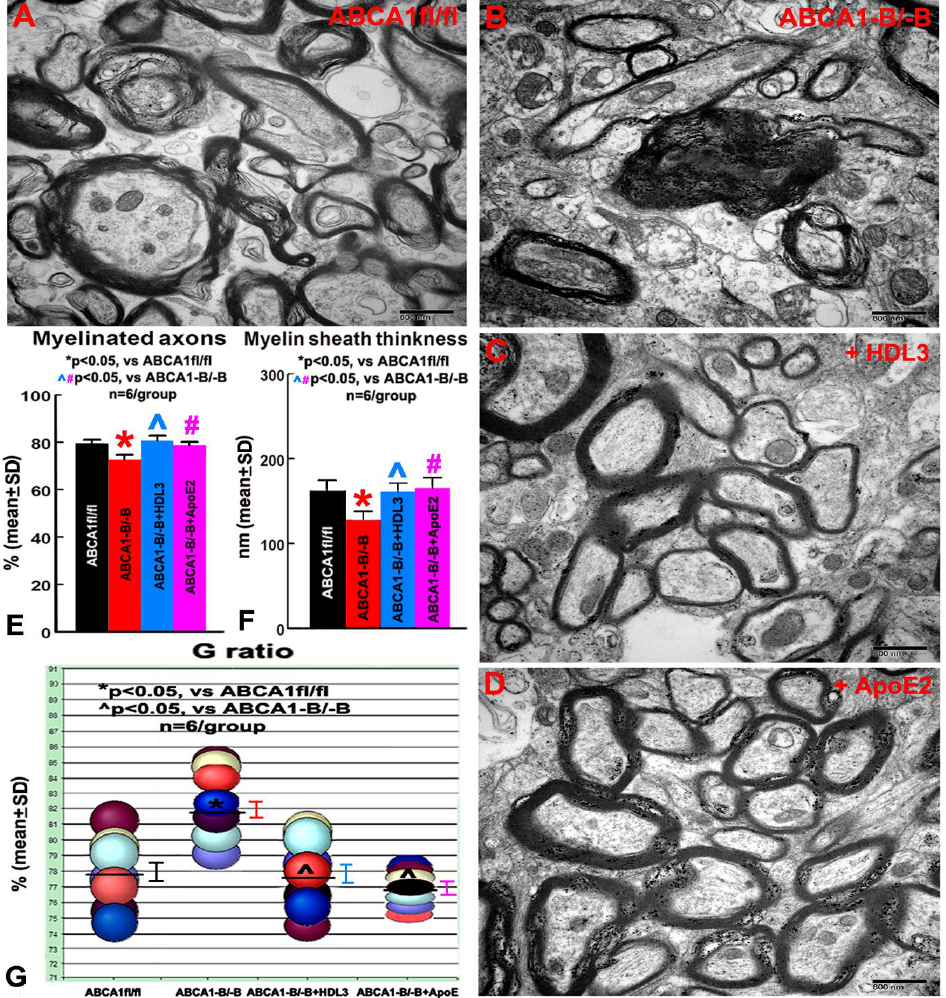
Figure 3. The electron microscopy (EM) images from the ischemic boundary zone (IBZ) of WM in ipsilateral ischemic brain show that ABCA1 -B / -B stroke mice exhibited decreased myelination compared with ABCA fl / fl stroke mice. However, intracerebral administration of HDL3 or ApoE2 significantly increased myelination in the IBZ of WM in ABCA1 -B / -B stroke mice. ( A ) WM in the IBZ of ABCA fl / fl stroke mice. ( B ) WM in the IBZ of ABCA -B / -B stroke mice. ( C ) WM in the IBZ of ABCA -B / -B stroke mice administered with HDL3. ( D ) WM in the IBZ of ABCA -B / -B stroke mice administered with ApoE2. ( E ) Quantitative data of myelinated axons. ( F ) Quantitative data of the myelin sheath thickness. ( G ) Quantitative data of the G ratio. * p < 0.05, vs. ABCA1 fl / fl stroke mice; #, ˆ p < 0.05, vs. ABCA1 -B / -B stroke mice. Scale bar = 800 nm, n = 6/group.